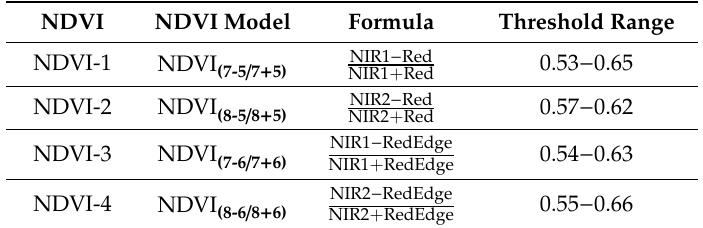
Table 2. Customized normalized di ff erence vegetation index (NDVI) devised as an e ff ective semi-automatic extraction tool for vegetation mapping application.